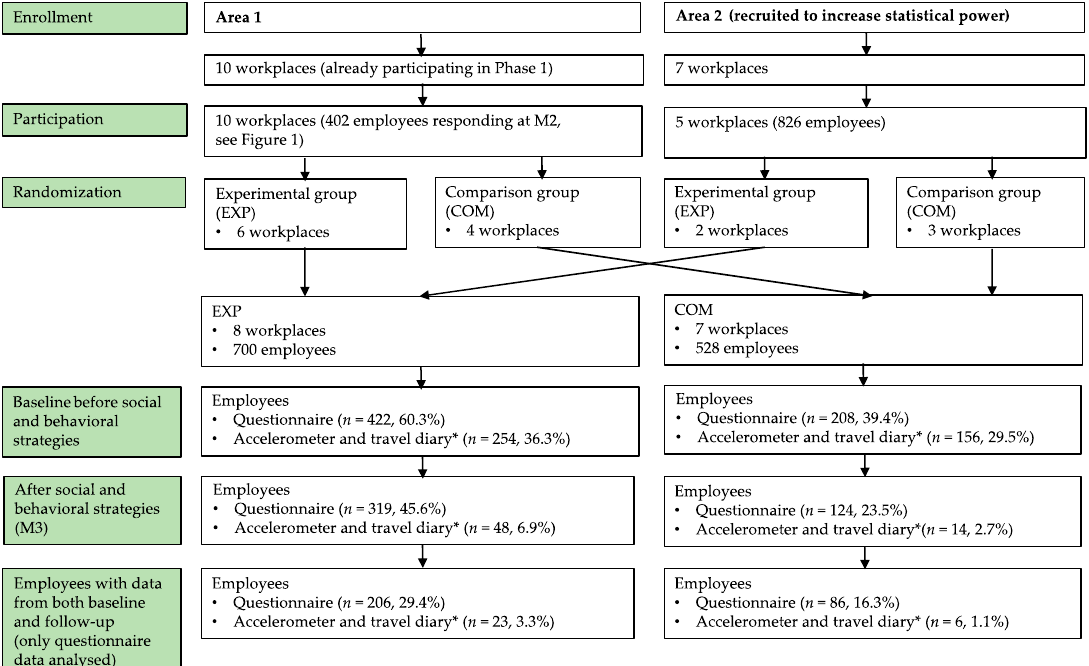
Figure 2. Flow chart of Phase 2 (workplaces in Area 1 and Area 2): Effectiveness of workplace-specific social and behavioral strategies in a cluster-randomized controlled design.